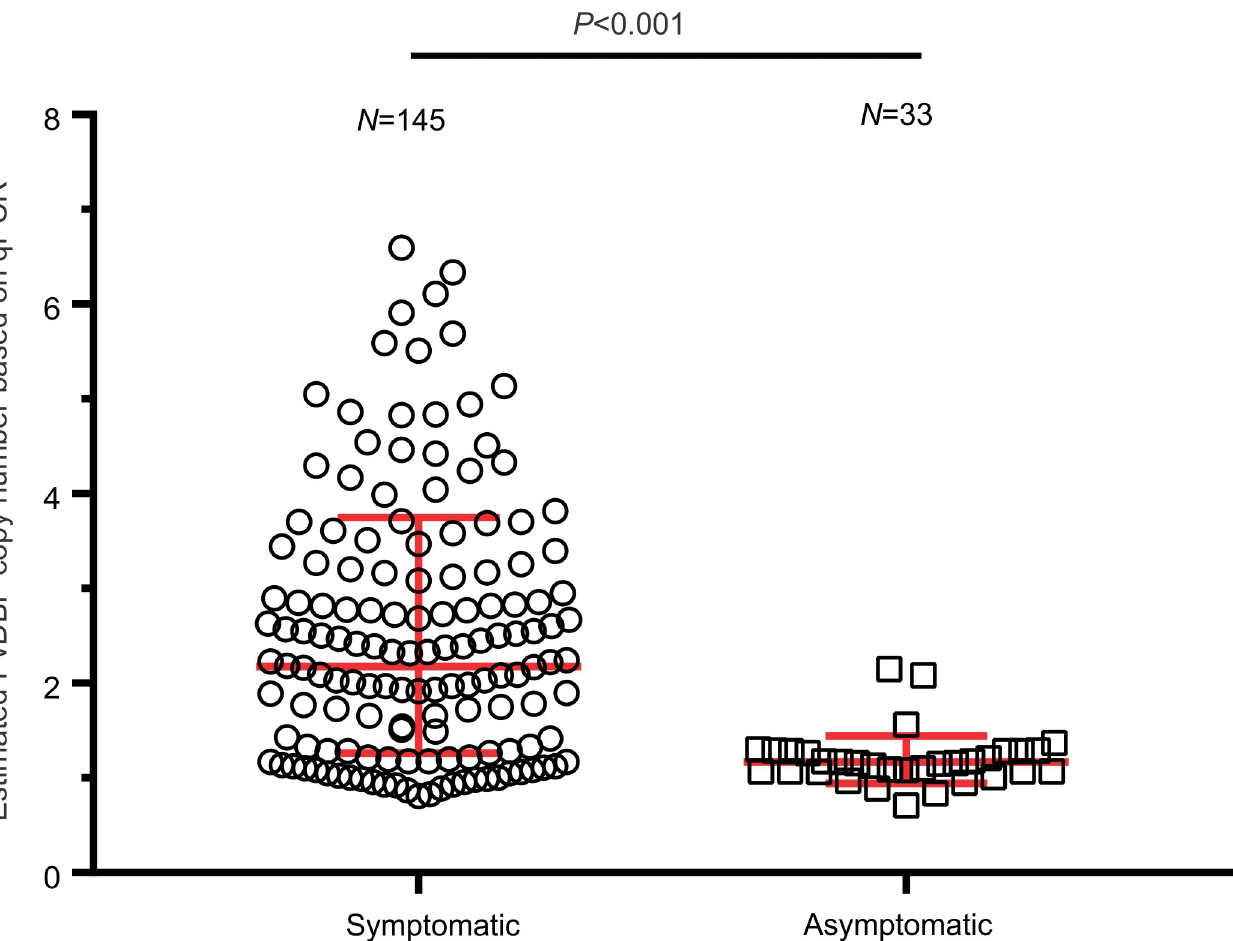
Fig 3. Comparison of PvDBP copy number in symptomatic and asymptomatic P . vivax samples. PvDBP copy number was estimated by qPCR. The geometric median and stand deviation of the data were shown for each type of infection.